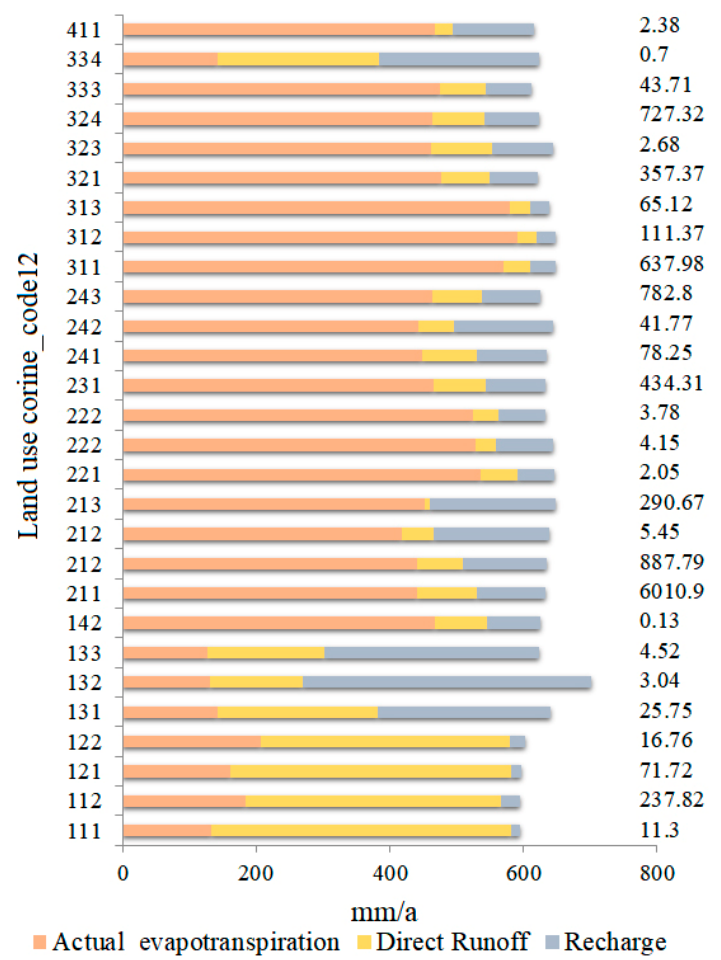
Figure 7. Long-term monthly groundwater recharge for the period 1991–2010.